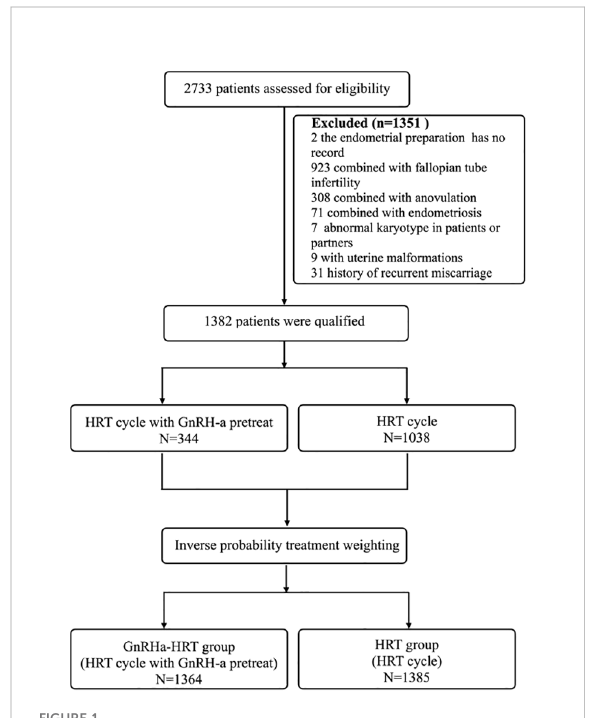
FIGURE 1 Trial pro fi le. HRT, hormone replacement therapy; GnRH-a, gonadotropin-releasing hormone